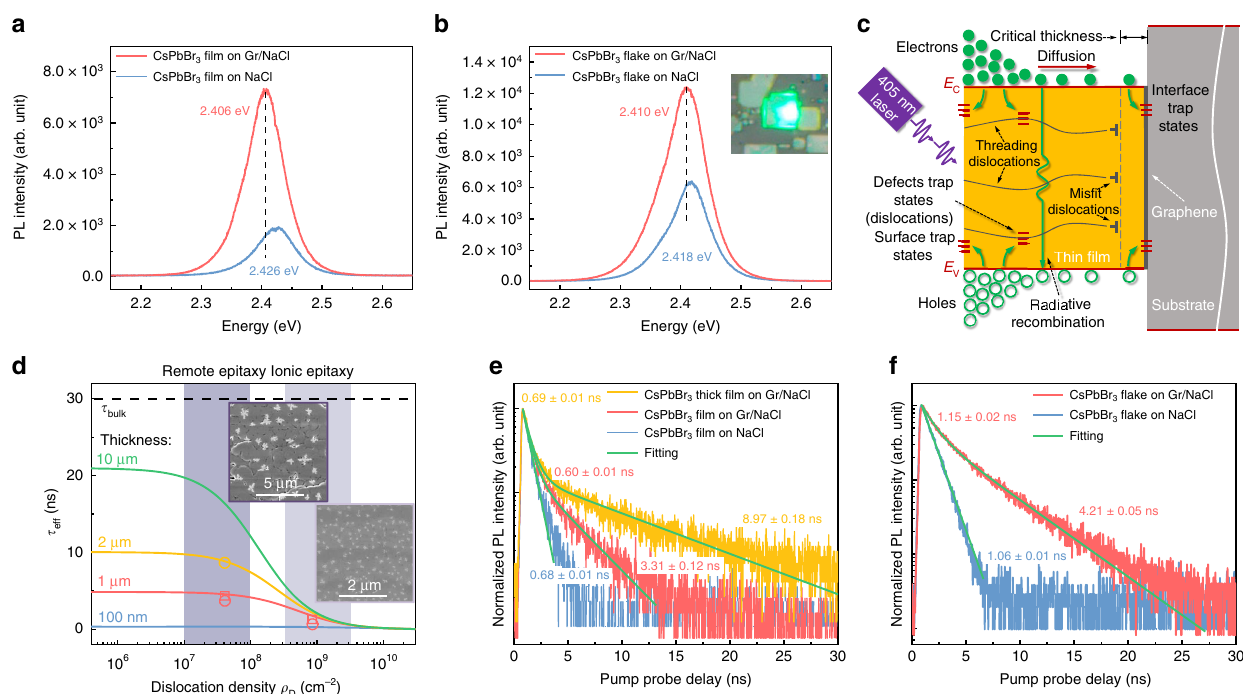
Fig. 5 Dislocation-carrier dynamics relation in remote and ionic epitaxy. a , b , Steady-state PL of CsPbBr 3 fi lms ( a ) and fl akes ( b ) in both remote and ionic epitaxy. c Schematic illustration of carrier dynamics in CsPbBr 3 . d Effective carrier lifetime as a function of dislocation density with different sample thickness and SEM images for ionic (right one) and remote (left one) epitaxial samples after etching. Experimental data for thin fi lm and fl ake are indicated in circle and square, respectively. Remote epitaxy and ionic epitaxy regions painted in dark purple and light purple, respectively. e , f , TRPL of CsPbBr 3 fi lms ( e ) and fl akes ( f ) in both remote and ionic